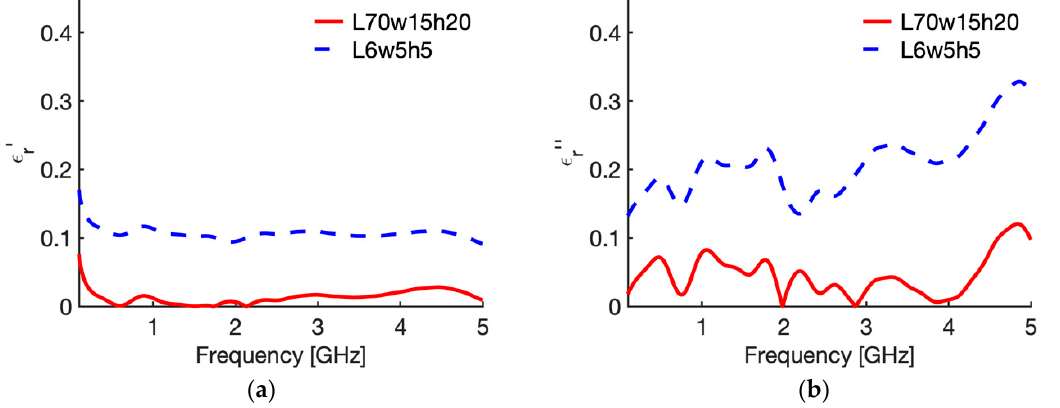
Figure 10. Percentage errors in the evaluation of the relative complex permittivity of fat at 25 °C through the reflection arrangement of the open probe technique. ( a ) real part; ( b ) imaginary part. The red curves give the error evaluated in the reference case, while the dashed blue line shows the error in the case where the maximum average error was calculated, i.e., case 10 in Table 2 (6; 5; 5; air).